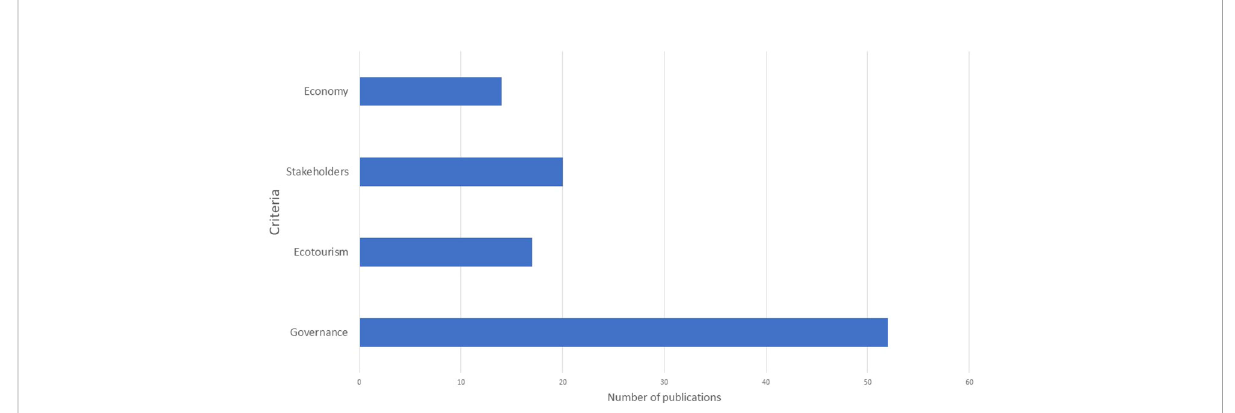
FIGURE 4 Number of publications in which the articles partially meet the de fi ned